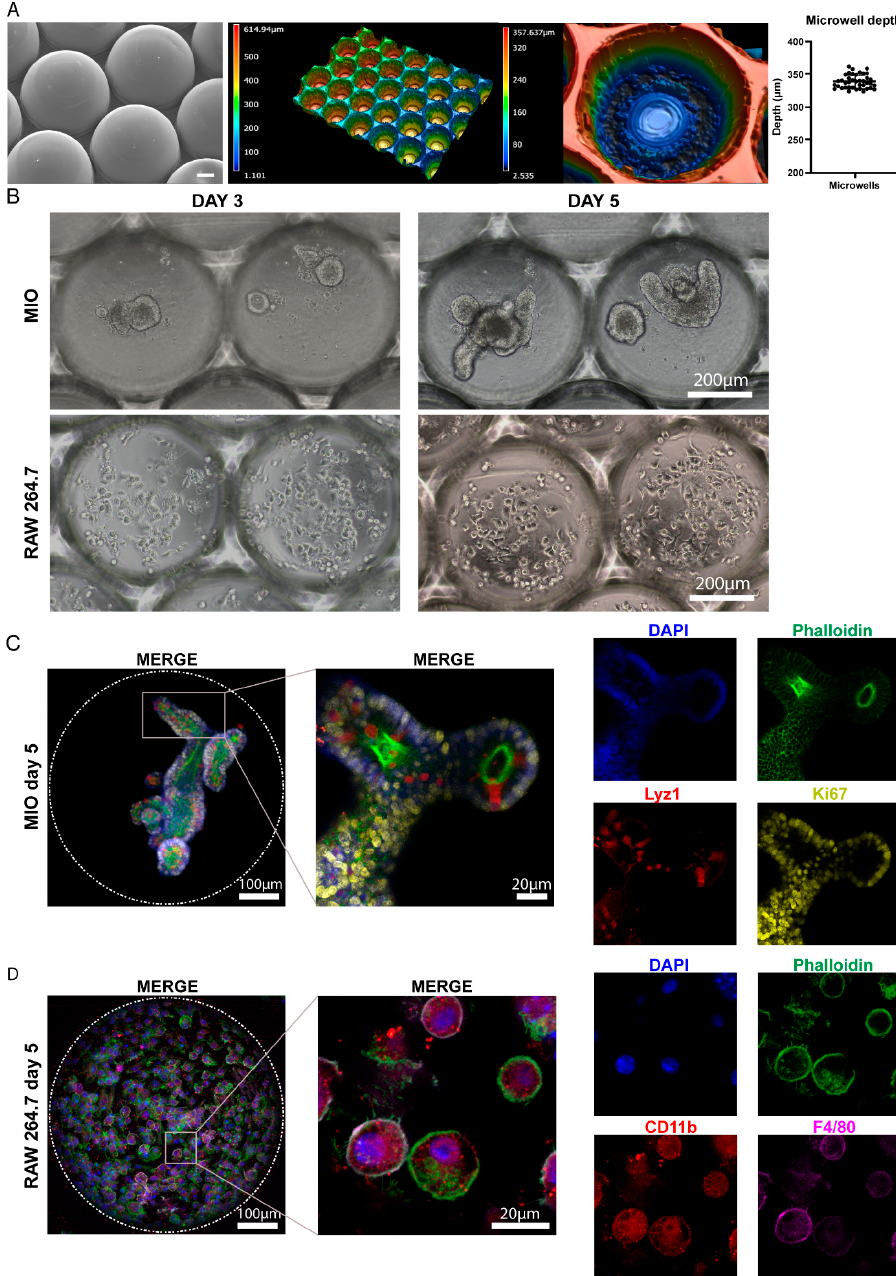
Figure 1. Monocultures of organoids (MIO) and RAW 264.7 cells in microwells. ( A ) Characterization of the thermoformed microwell arrays was performed using SEM (Jeol, Nieuw-Vennep, Benelux) and confocal laser scanning microscopy (Leica, Wetzlar, Germany). The graph indicates the depth of the microwells. Data are presented as the mean ± SEM. ( n = 4). Scale bar represents 100 μ m. ( B ) Bright-field images demonstrating the growth of the organoids (top) and macrophages (bottom) over a period of 5 days. ( C ) Immunofluorescence stainings of intestinal organoids grown in microwells for the F-actin marker phalloidin (green), the Paneth cell marker Lyz1 (red), and the proliferation marker Ki67 (yellow). Dashed circle represents the circumference of the microwells. The white square represents the area magnified in the respective column to the right. ( D ) Immunofluorescence stainings of RAW 264.7 cells grown in microwells for phalloidin (green) and the macrophage markers CD11b (red) and F4/80 (magenta). Dashed circle represents the circumference of the microwells. The white square represents the area magnified in the respective column to the right. Abbreviations: MIO, mouse intestinal organoid; DAPI, 4 (cid:48)